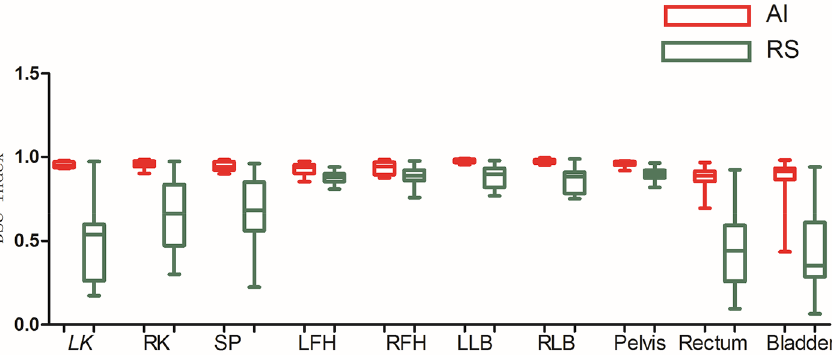
Figure 4. Comparison results of DSC between two software in automatic delineation of rectal cancer